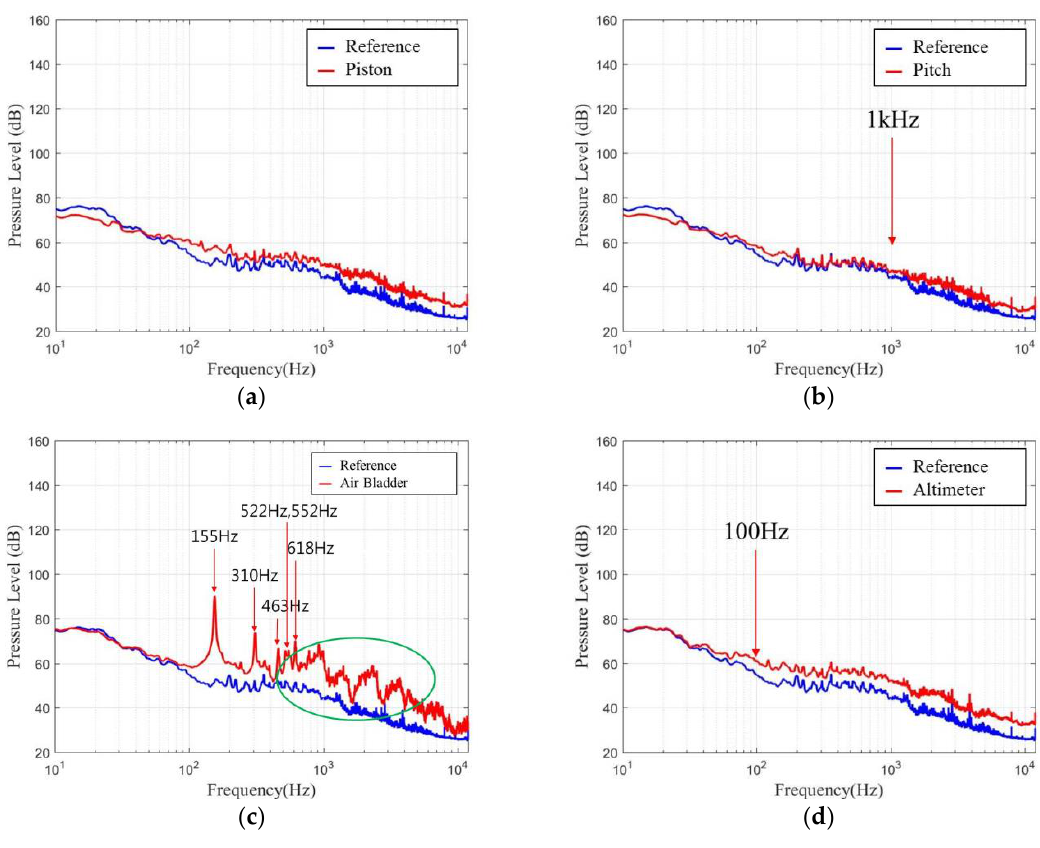
Figure 4. Measurement noise level when the underwater glider operates in the laboratory tank: ( a ) Piston, ( b ) Pitch, ( c ) Air Bladder, and ( d ) Altimeter.